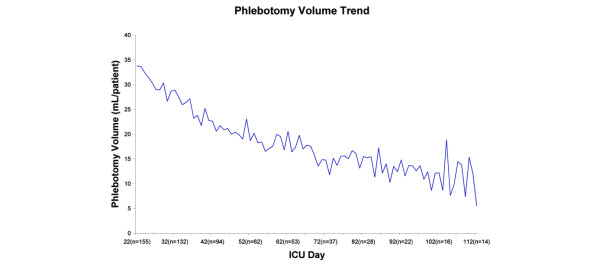
Phlebotomy volume over time. ICU, intensive care unit.